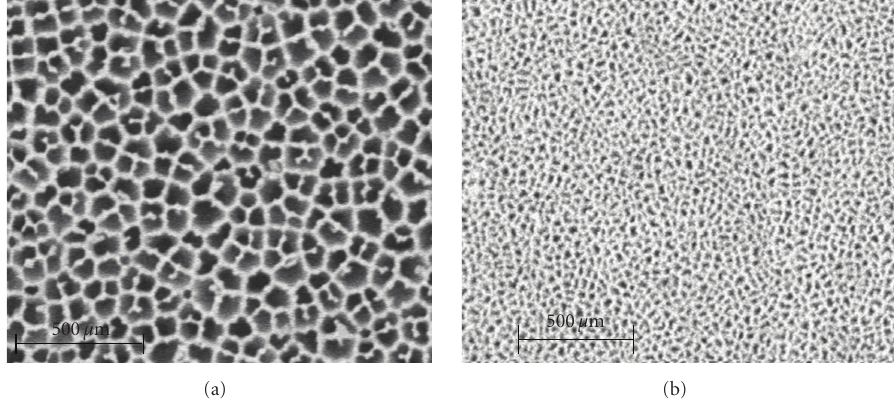
Figure 1: SEM micrographs showing nanoporous alumina membranes with pore diameters of 200nm (a) and 20nm (b).